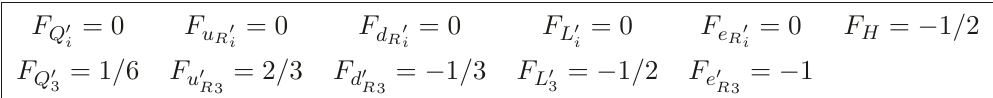
Table 1 . U(1) F charges of the (cid:12)elds in the Third Family Hypercharge Model, where i 2 f 1 ; 2 g .